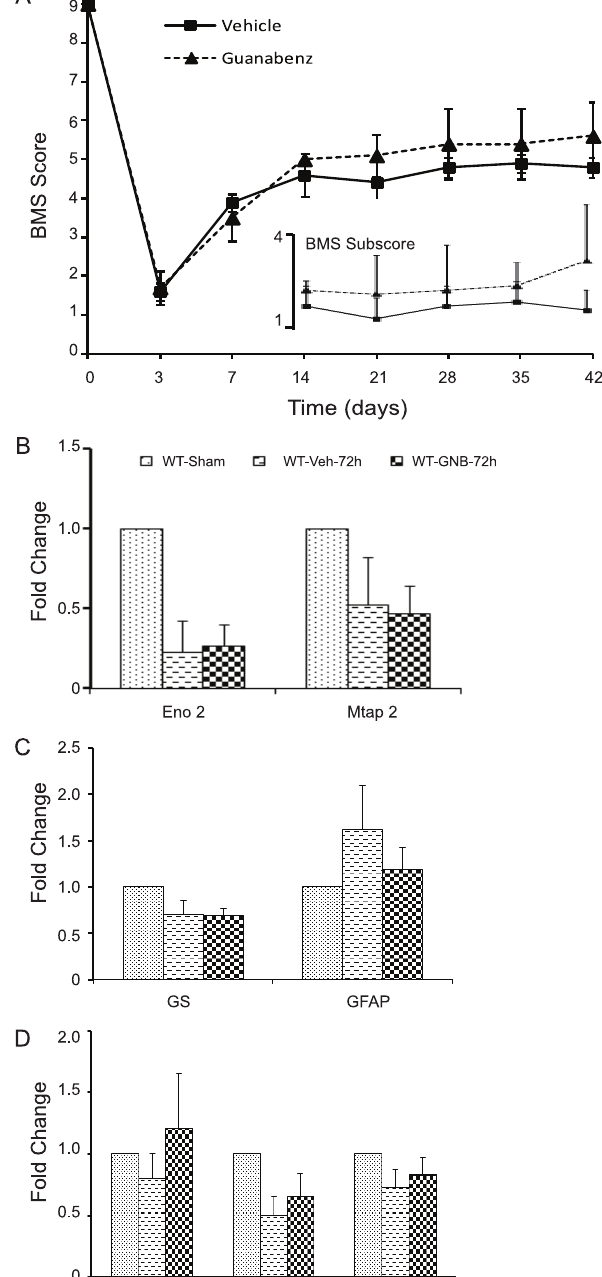
Figure 7. Administration of guanabenz does not enhance hindlimb locomotor function after SCI. (A) Open field BMS locomotor analyses performed weekly did not reveal any significant differences between vehicle- and guanabenz-treated animals. Analysis of BMS subscore also did not show any differences in stepping characteristics between the two groups (inset). Guanabenz treatment does not result in significant differences in the neuron- (B), astrocyte-(C) and oligodendrocyte-specific (D) transcript levels (as indicated) compared to vehicle-treated mice at 72 hours post-SCI. Data (A,B) are the mean 6 SD